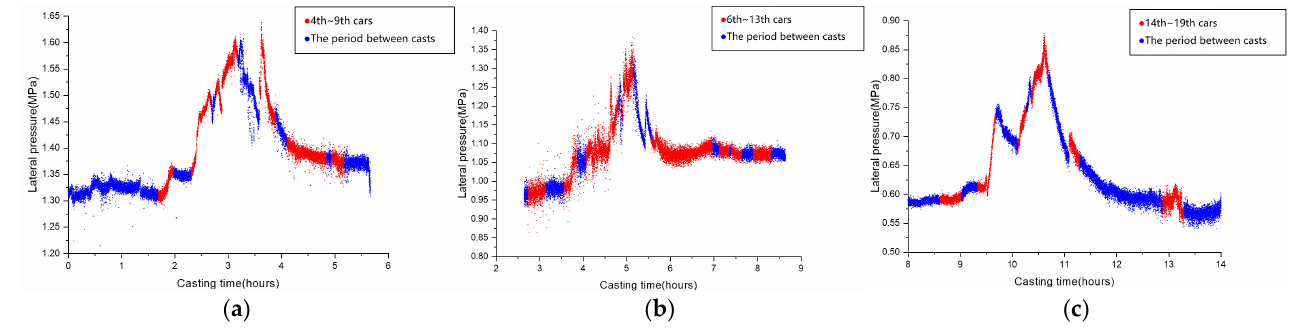
Figure 5. Effect of the number of casts on lateral pressure at depths of 100 m, 80 m and 40 m. ( a ) The depth of the measurement point is 100 m; the red dots indicate the casting period (fourth to ninth cars), and the blue dots indicate the period between casts. ( b ) The depth of the measurement point is 80 m; the red dots indicate the casting period (6th to 13th cars), and the blue dots indicate the period between casts. ( c ) The depth of the measurement point is 40 m; the red dots indicate the casting period (14th to 19th cars), and the blue dots indicate the period between casts.